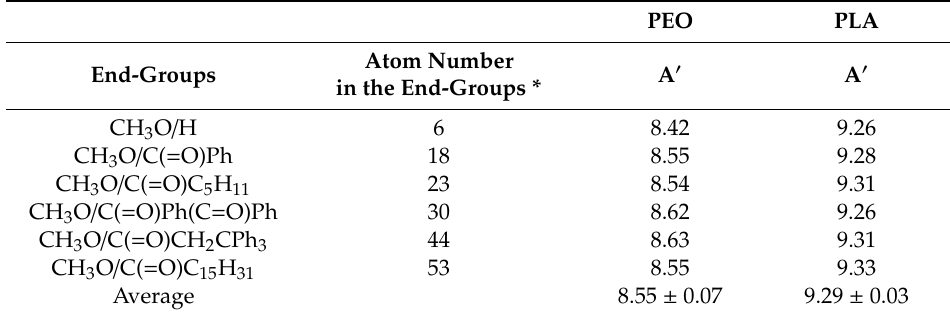
Table 3. Collision cross section evolution as a function of the atom numbers—parameters obtained from fitted curves for a CCS = A (cid:48) nAtoms 2 3 equation (See Figures S5 and S6). PEO PLA Atom End-Groups